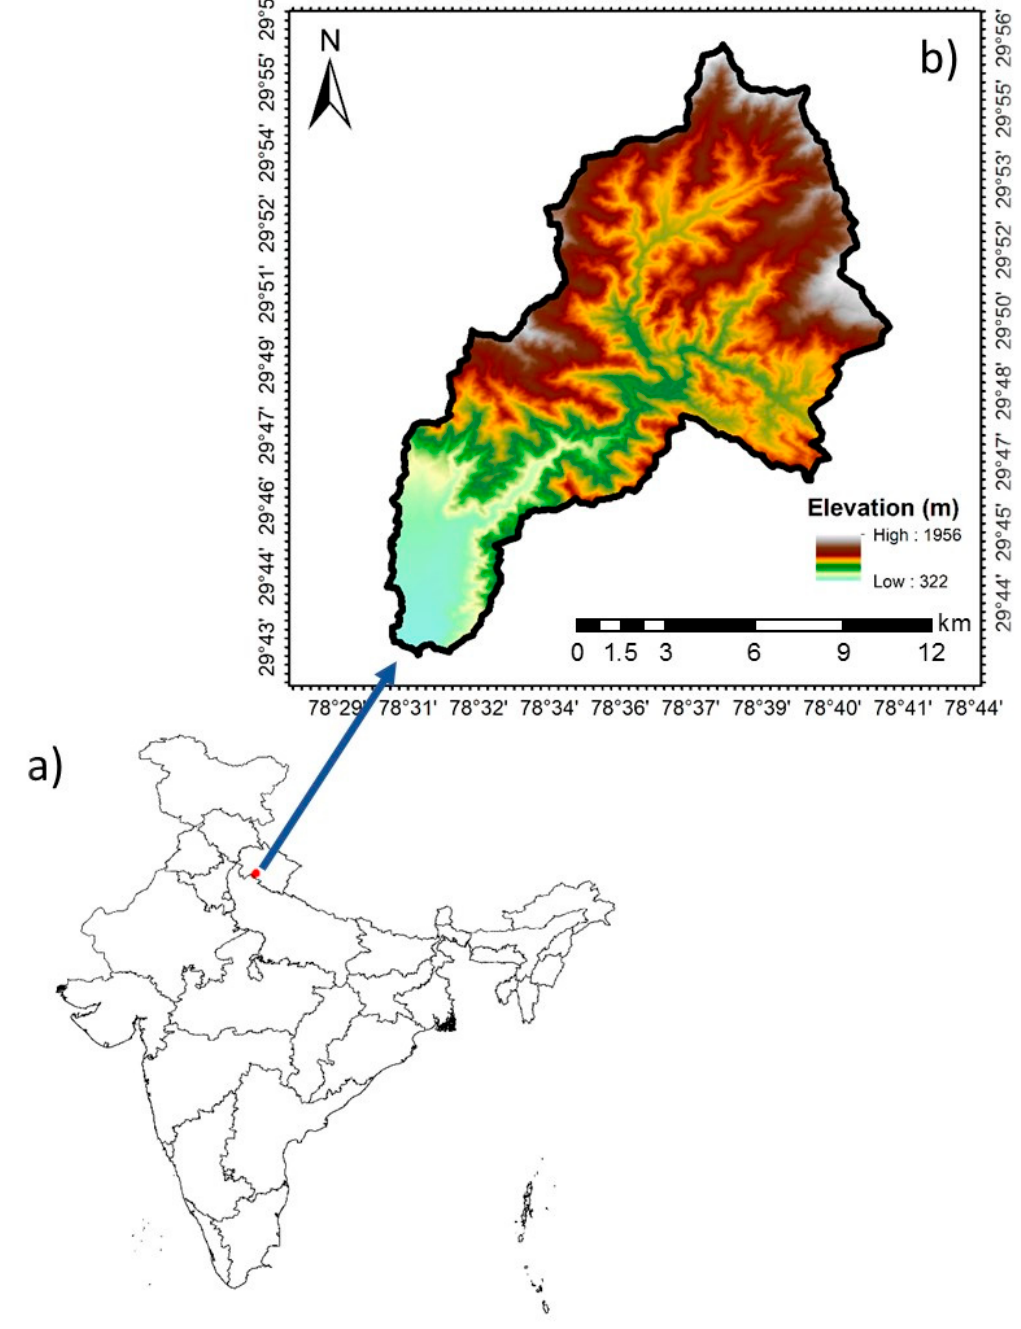
Figure 1. ( a ) The location map of the study area within India; ( b ) the index map of Upper Khoh River (UKR) Basin in Uttarakhand, India as an elevation